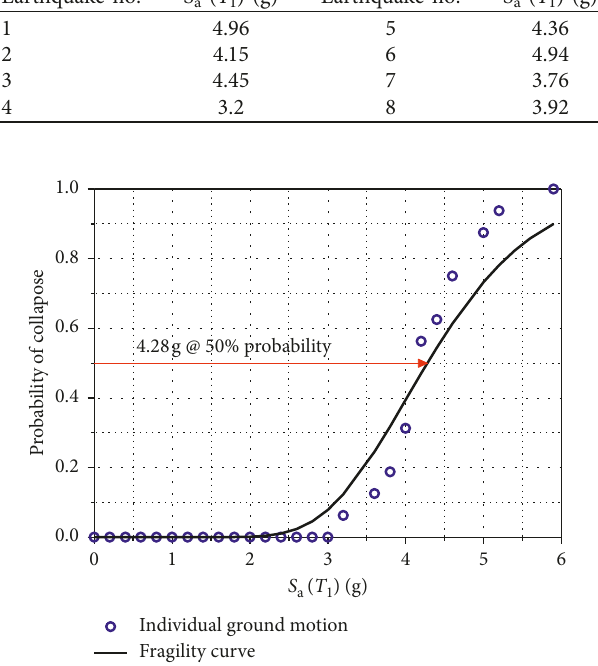
Figure 36: Collapse fragility curve of the